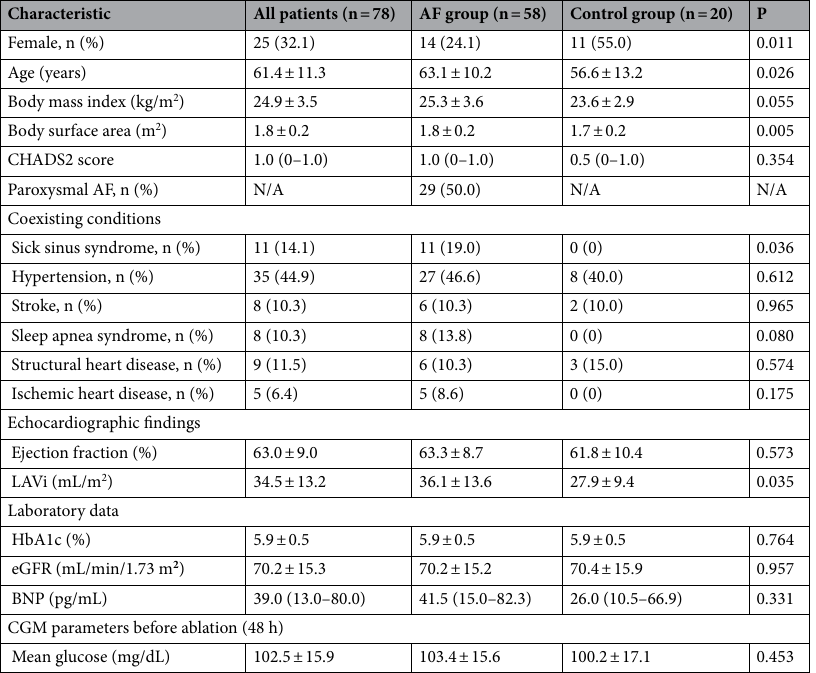
Table 1. Baseline clinical characteristics. AF atrial fibrillation, LAVi left atrial volume index, eGFR estimated glomerular filtration rate, BNP brain natriuretic peptide, CGM continuous glucose monitoring.